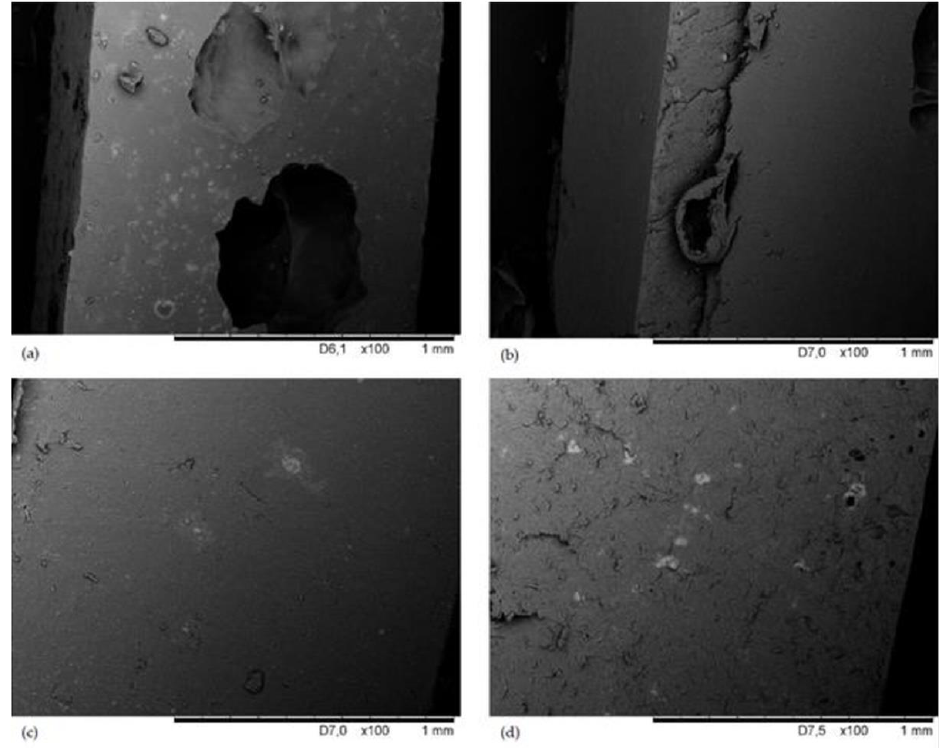
Figure 3. SEM images of the cross-section of CR/BR/Zn ( a ); CR/BR/Zn/sillitin ( b ); CR/BR/Zn/chalcedonite ( c ); and CR/BR/Zn/aerosil ( d ).